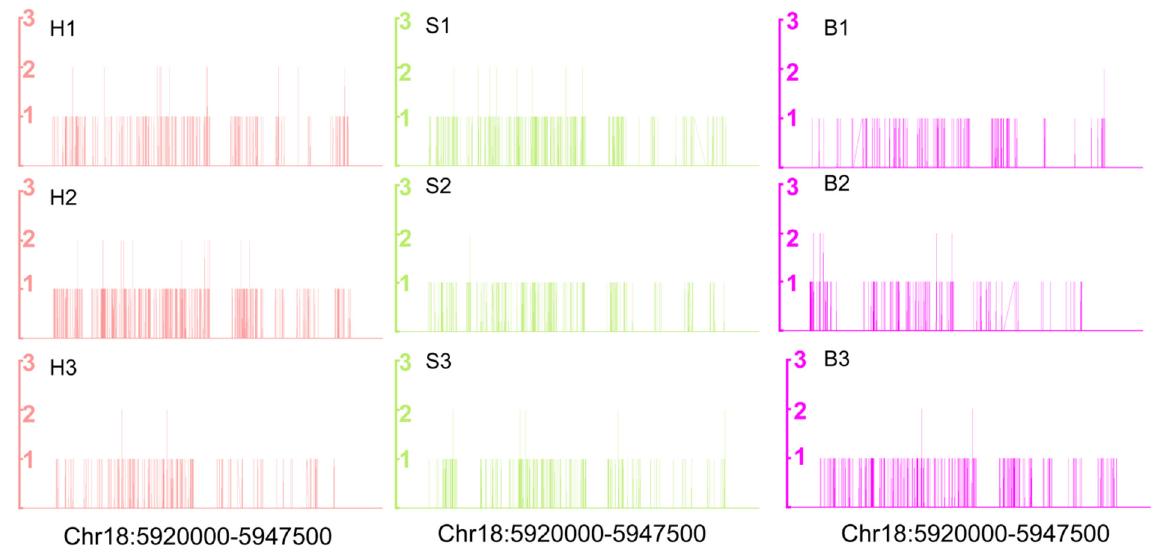
Figure 6. Variation of the DNA methylation pattern of MC5E (EVM0008148) in holdfast (H), stipe (S) and blade (B) through whole genome bisulfite sequencing.